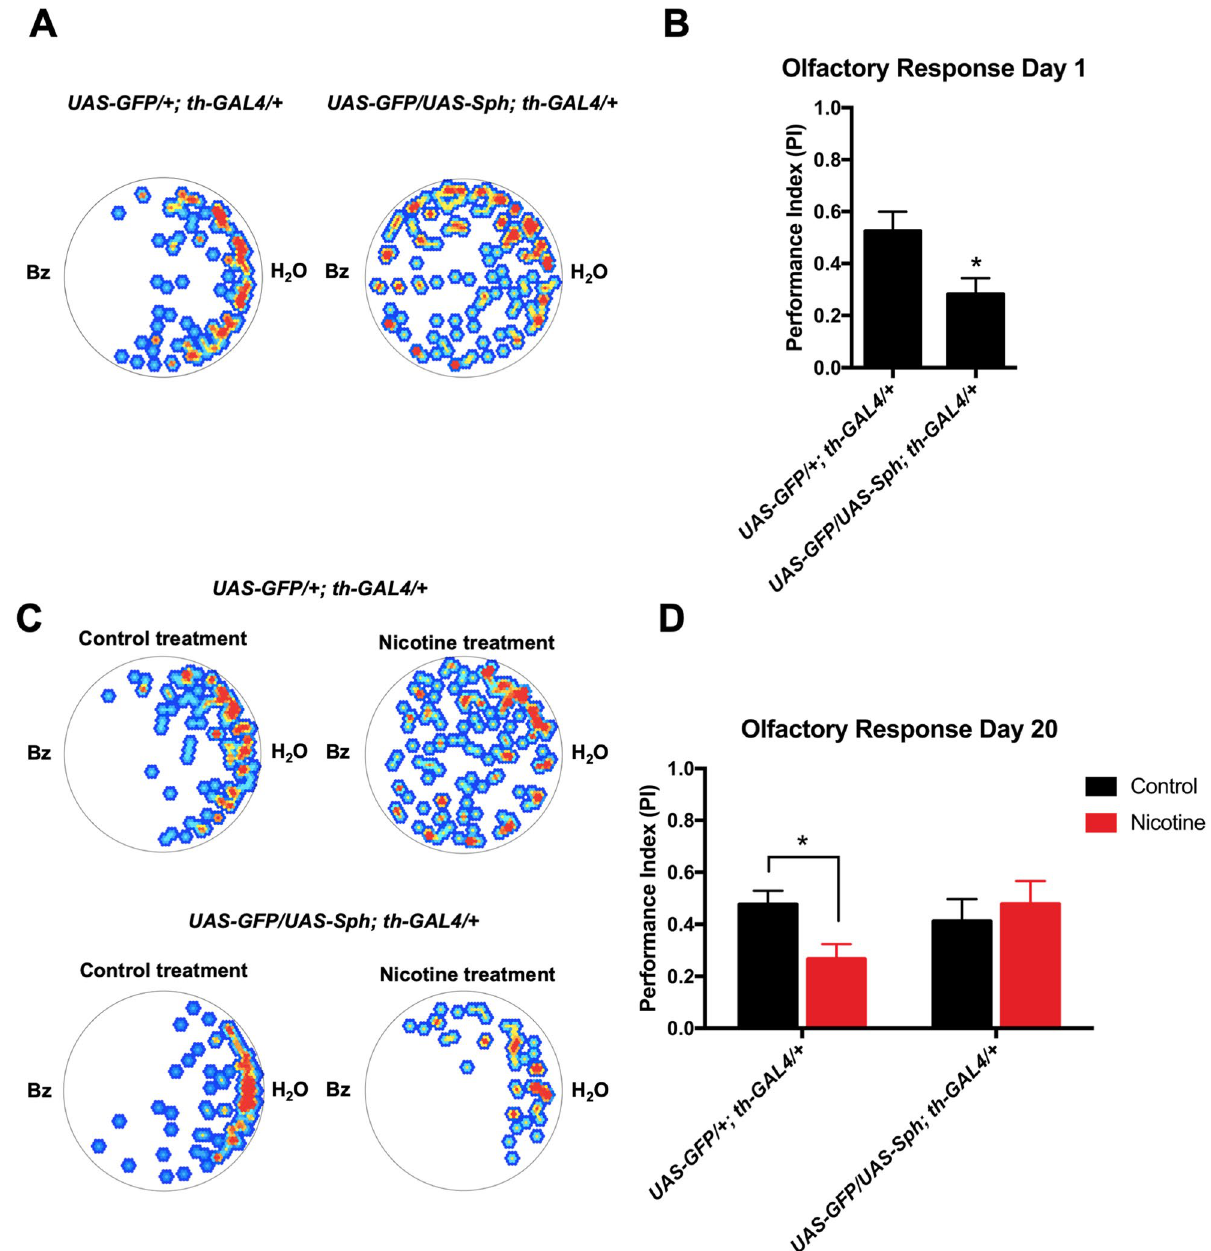
Figure 4. Young flies that express Sph-1 in dopaminergic neurons exhibit impaired olfactory responses. ( A ) Heat maps of a typical experiment showing the aversive response towards benzaldehyde (Bz) of recently eclosed flies of the control genotype ( UAS-GFP/ + ; th-GAL4/ +) and of flies expressing Sph-1 in dopaminergic neurons ( UAS-GFP/UAS-Sph; th-GAL4/ +). The position of flies over 3 min is presented in color ranges, where red or yellow hue represent points in the arena where flies spent longer time, while blue or white hue show regions in the arena where flies spent little or no time at all. In both cases, Bz was placed to the left side of the arena. B) Quantification of the cumulative behavior of the flies tested for each genotype expressed as Performance Index. These data shows that aversive response is reduced in Sph-1 expressing flies compared with control flies. C) Representative heat maps of behavior of flies (20 days old) from both genotypes, after chronic treatment with nicotine, or in control condition (no treatment). D) Quantification of behavior of several flies (20 days old) show no difference in olfactory response between the two genotypes in control condition. Aged control flies treated with nicotine show reduced olfactory response compared with control flies not receiving the cholinergic agonist. Data from untreated animals were represented in black bars; data from nicotine-treated animals were represented in red bars. *P < 0.05, n = 15 animals per condition. Two-way ANOVA. Tuckey’s post-hoc test. All treated animals were chronically exposed to 24 µM